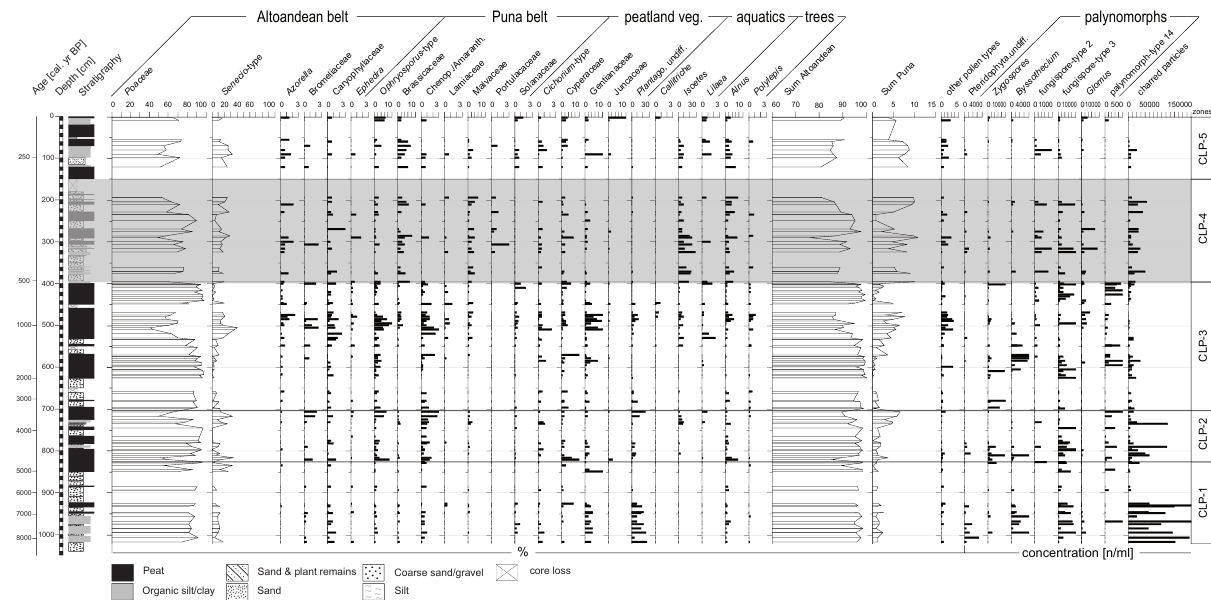
Figure 4. Pollen, palynomorphs and charred particles diagram for the Cerro Llamoca peatland, plotted against depth. Peatland vegetation and aquatic types were excluded from the pollen sum. The shaded zone is mainly composed of redeposited, erosional material.